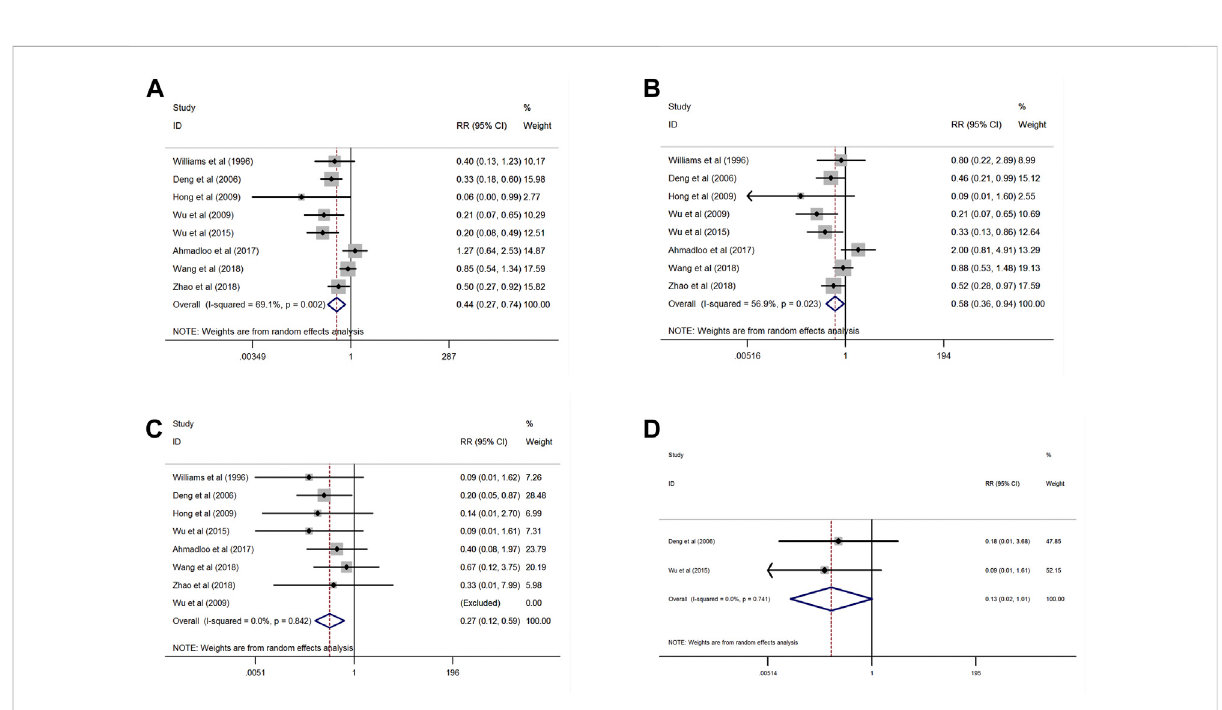
FIGURE 4 ForestplotsofthecumulativeanalysisoftheprotectiveeffectsdevelopedbyaloeverainGrade2 – 4 (A) ,Grade2 (B) ,Grade3 (C) ,andGrade4 (D) radiation-induced dermatitis (study group: n = 401; control group: n =